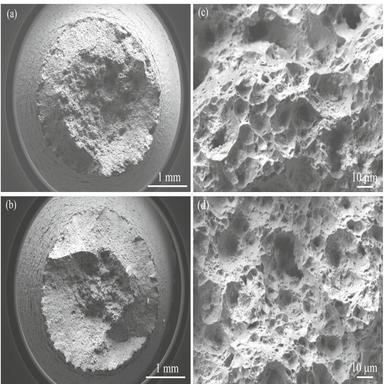
Fracture surfaces of crept samples at (a and c) 150 and (b and d) 210 MPa.